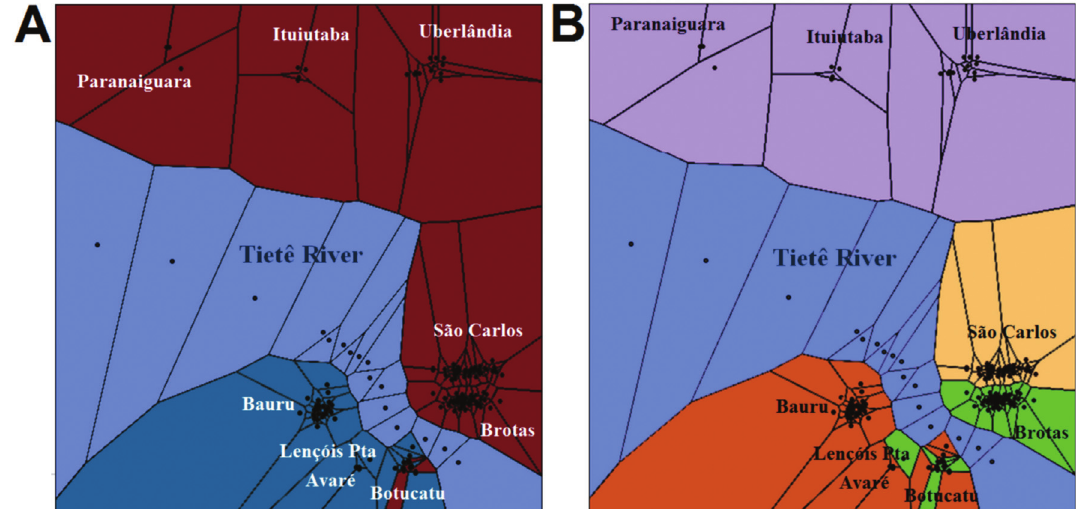
Figure 3 - Spatial structure. Clusters produced by the TESS analysis, in which each individual is assigned to the group with which it shares most ancestrality (> Q). (A) k = 2, (B) k = 4. The dummy points, which are points where no population were sampled, represent the Tietê River (light blue). The same color scheme was used as for the STRUCTURE analysis (Figure 2) in order to facilitate